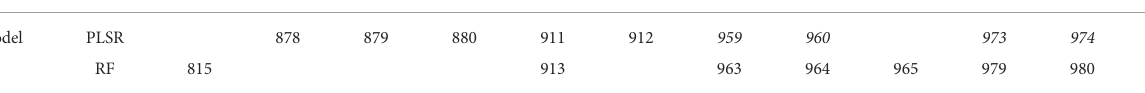
TABLE 2 Top wavelengths identi fi ed through variable importance analysis for predicting root starch content with partial least squares regression (PLSR) and random forest (RF) models using data captured with SCiO ™ for all combined cassava breeding fi eld trials at